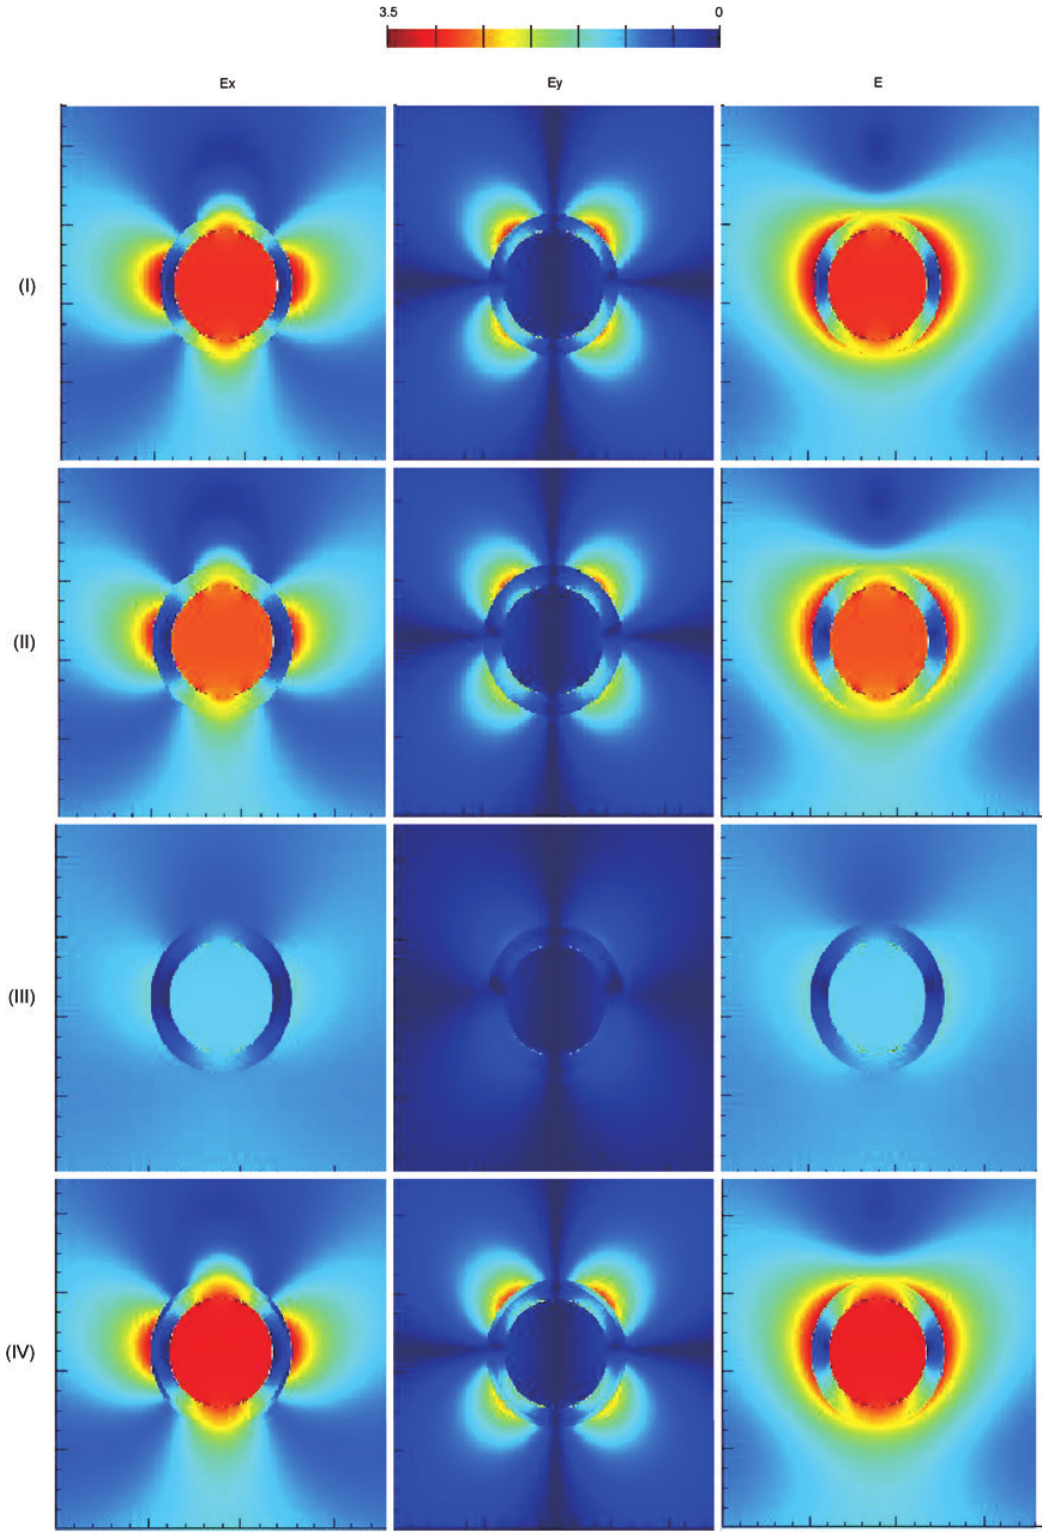
Figure 4: Electric field enhancement distributions on the x-y plane center cross-section of the (I) bare Ag@Au HNS individual nanoparticle with SPR peak at 575 nm; (II) J-aggregate-doped Ag@Au HNS ensemble with SPR peak at the upper branch ( ω doped Ag@Au HNS ensemble with SPR peak at the minimum; and (IV) J-aggregate-doped Ag@Au HNS ensemble with SPR peak at the lower branch ( ω ) maximum. Here the three columns correspond to Ex, Ey, and −